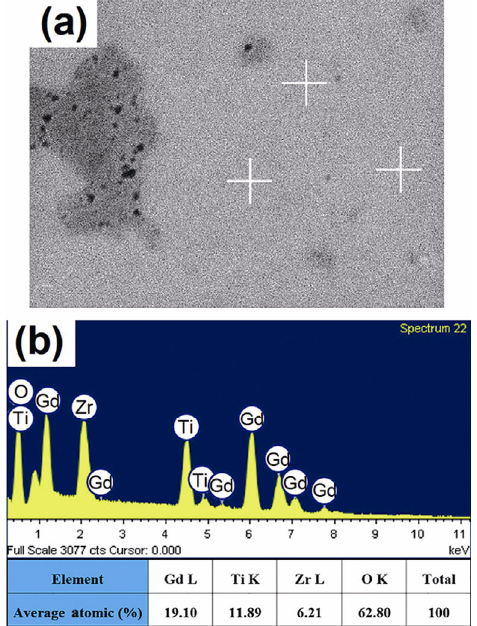
Fig. 7 EDX elemental spotting analysis: (a) represent BSE image of Zr-35 sample, (b) element spotting analysis.